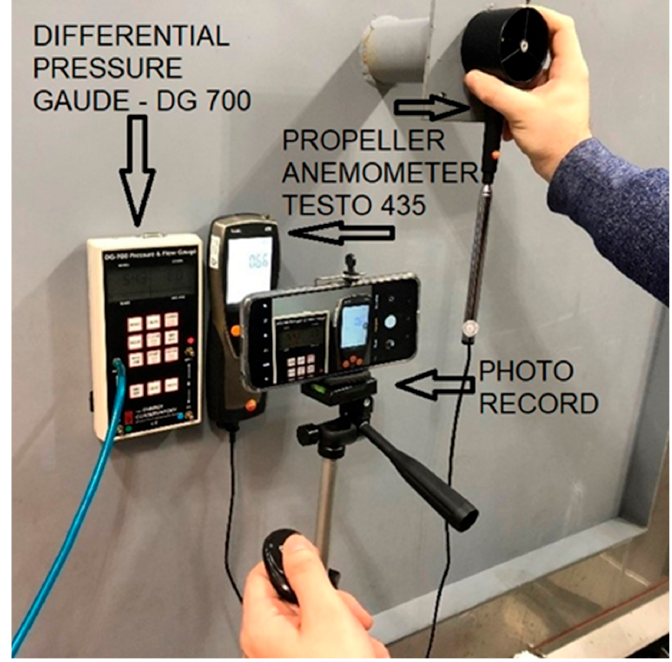
Figure 6. Airflow measurement with photographic record.